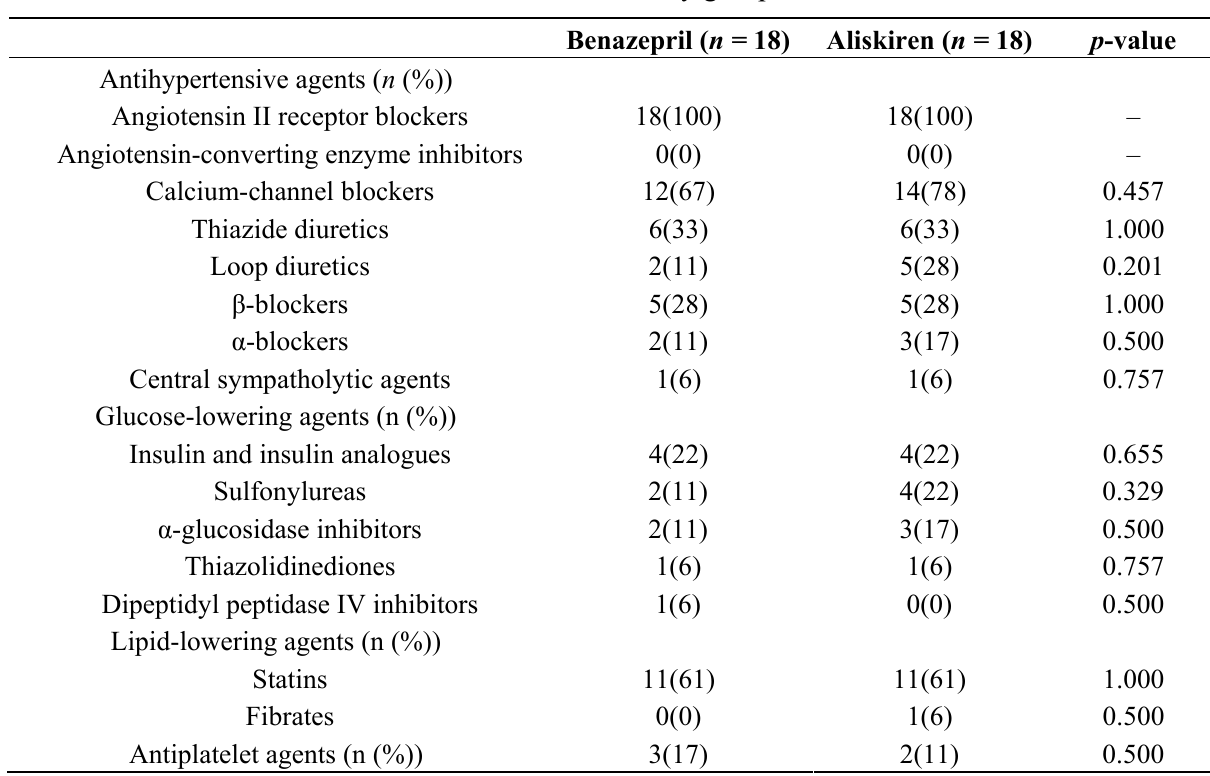
Table 2. Medication in the study groups at